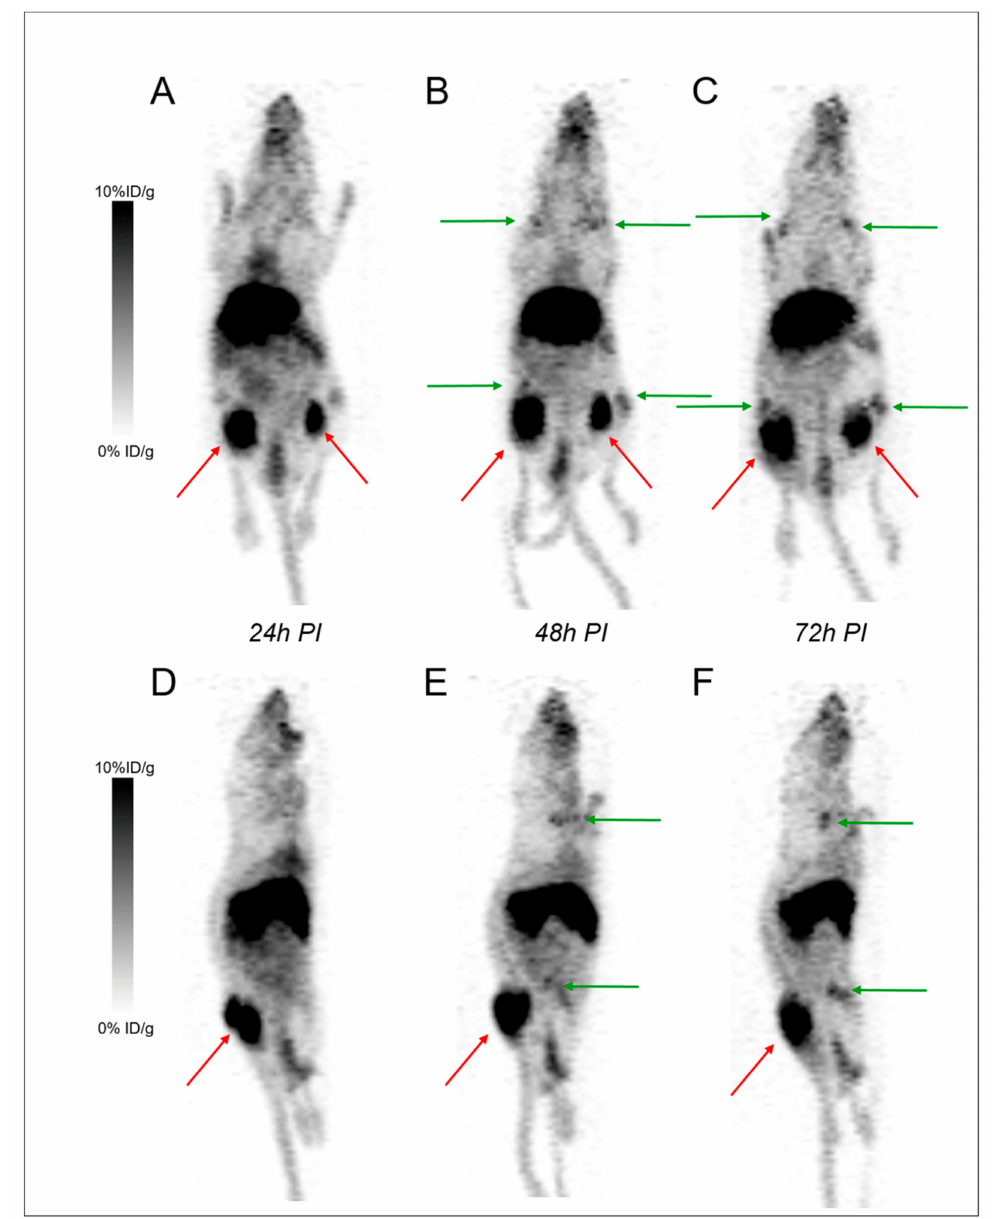
Figure 3. PET imaging with 89 Zr-DFO-9E7.4 in the subcutaneous (SC) model. Maximum intensity projections of PET imaging at 24 h post-injection (PI) ( A ; D ), 48 h PI ( B ; E ) and 72 h PI ( C ; F ) showing uptake of a subcutaneous tumor and of an inguinal lymph node (Tumors are indicated by red arrows) (Mouse 8). Green arrows showed conspicuous binding of free 89 Zr over time at sites of osseous